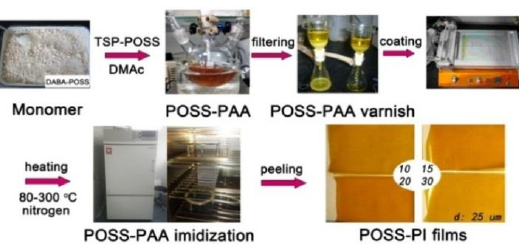
Figure 2. Synthesis of POSS-poly(amic acid) (PAA) varnishes and the derived POSS-polyimide (PI) composite films.